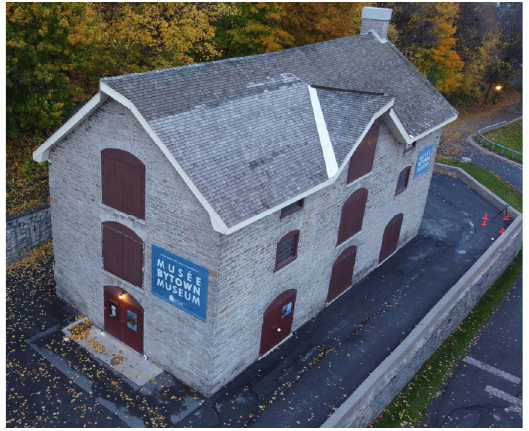
Figure 1. Bytown Museum